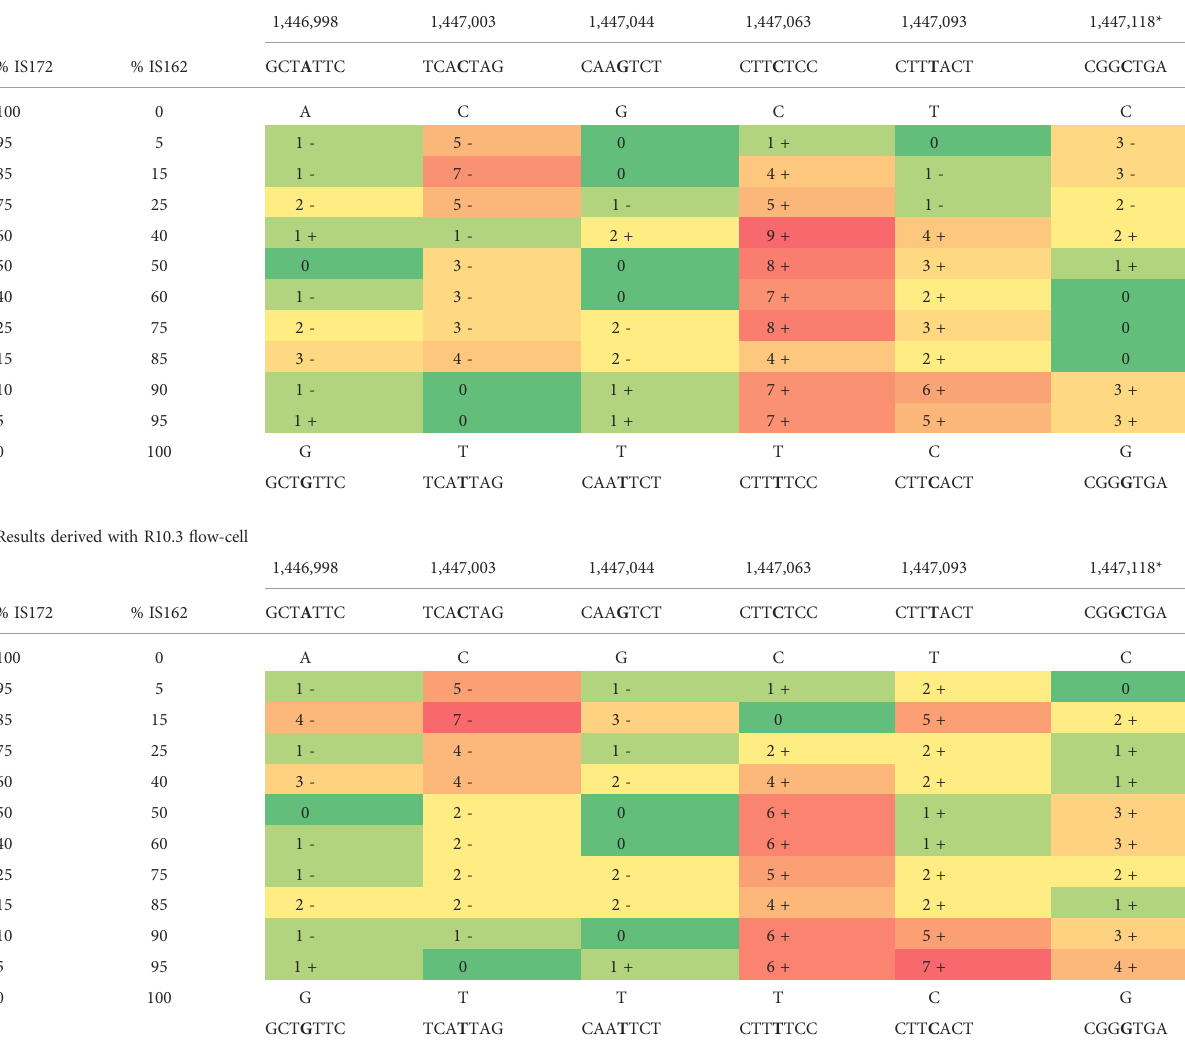
TABLE 3 Variability between the expected and observed percentages of each polymorphism in IS172 and IS162 mixtures. Results derived with R9.4 fl ow-cell